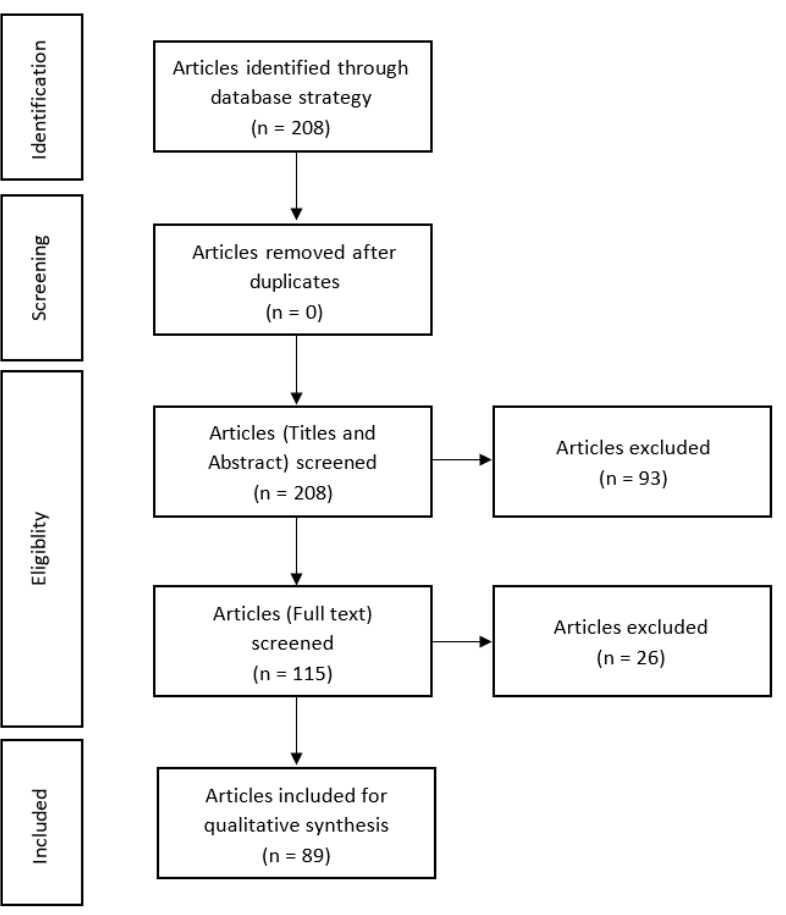
Figure 1. PRISMA flow diagram showing results of the literature search.